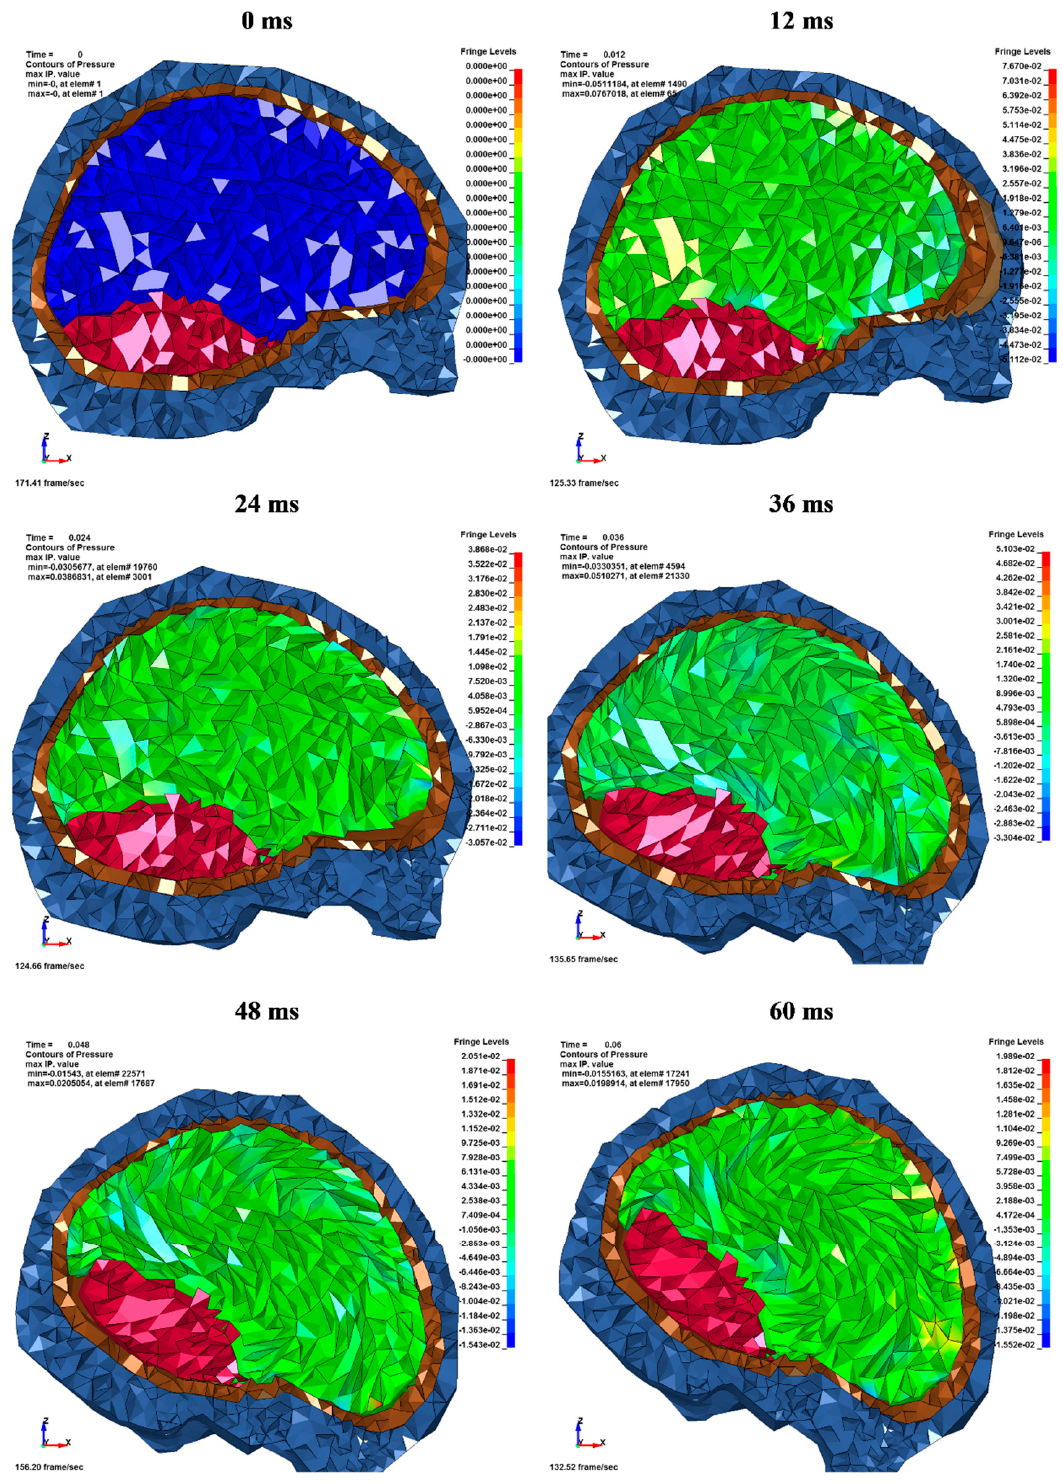
Figure 7. Head kinematics during the C755-T2 numerical test, with the cross-section in the median plane and showing the hydrostatic pressure (MPa) in the cerebrum.